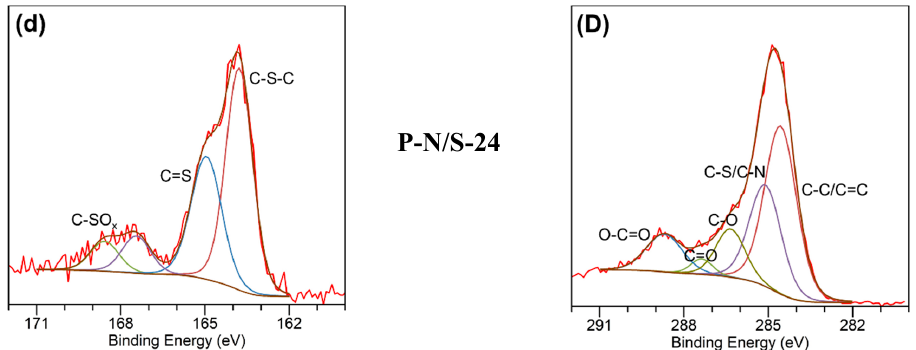
Figure 2. XPS S2p (left, a–d ) and C1s (right, A–D ) spectra for petcoke before and after acid treatment. The untreated petcoke had a total acidity of 0.34 mmol/g, and both the total acidity and the H + exchange capacity (i.e., strong acid acidity) increased with all acid treatments. Specifically, the strong acid contents were 0.25 mmol/g, 0.70 mmol/g, and 0.73 mmol/g for samples P-S-24, P-N-24, and P-